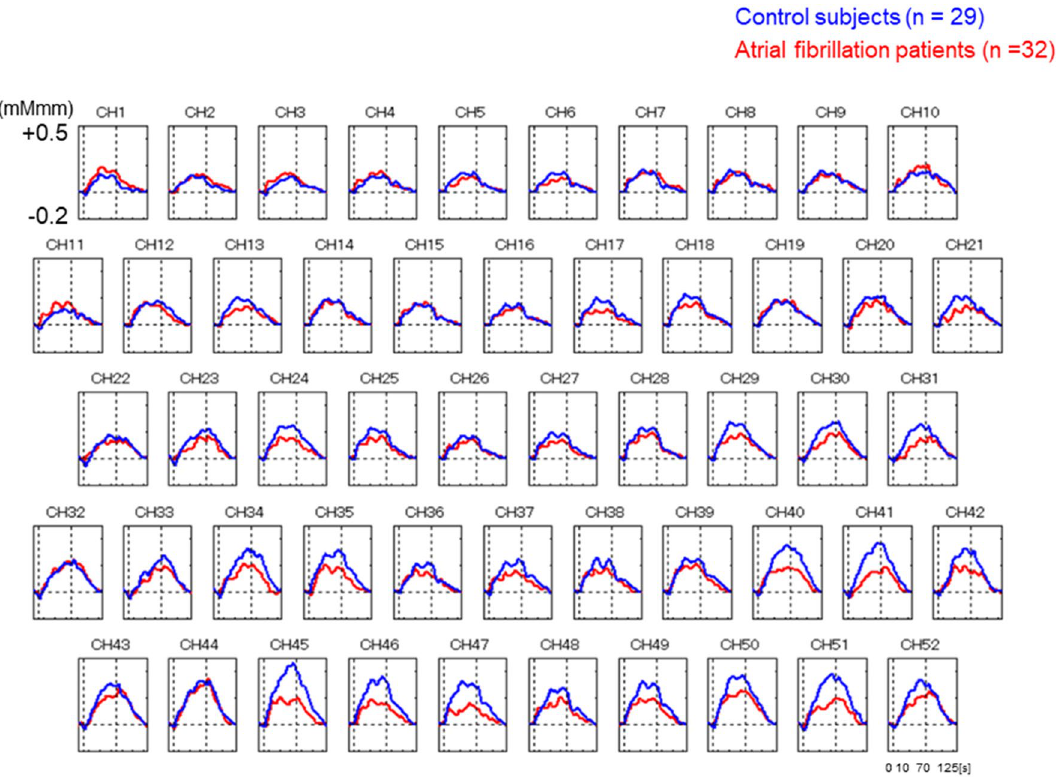
Figure 1. Comparison of grand average of waveform changes in oxyhemoglobin concentrations during verbal fluency task in the atrial fibrillation patients (red, n = 32) and control subjects (blue, n = 29). The horizontal axis represents time, and the vertical axis represents changes in mean oxyhemoglobin concentrations (mMmm) during the verbal fluency task.